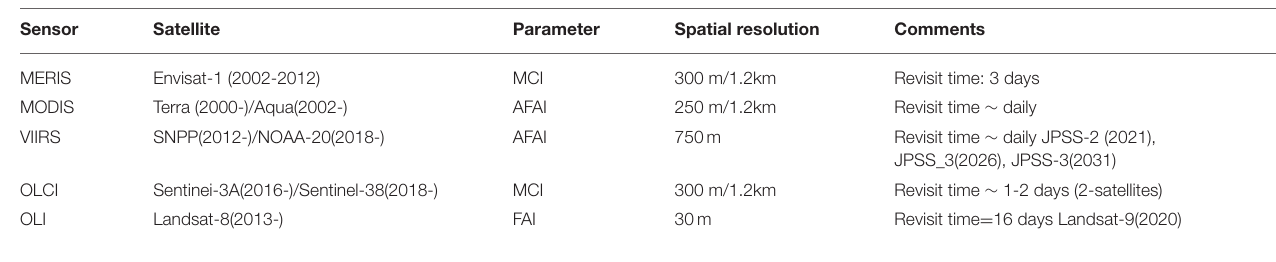
TABLE 1 | Main sensors being used to detect and track pelagic Sargassum . Sensor